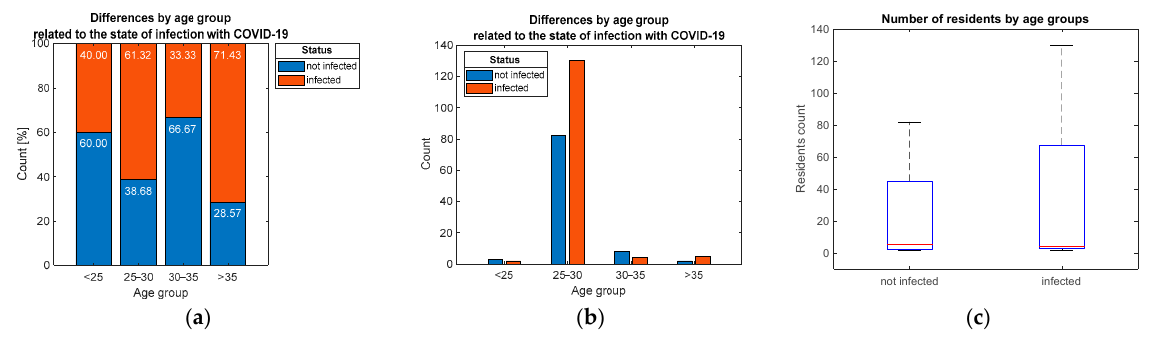
Figure 7. Distribution of respondents by: ( a ) percentage, ( b , c ) count considering differentiation by age group.